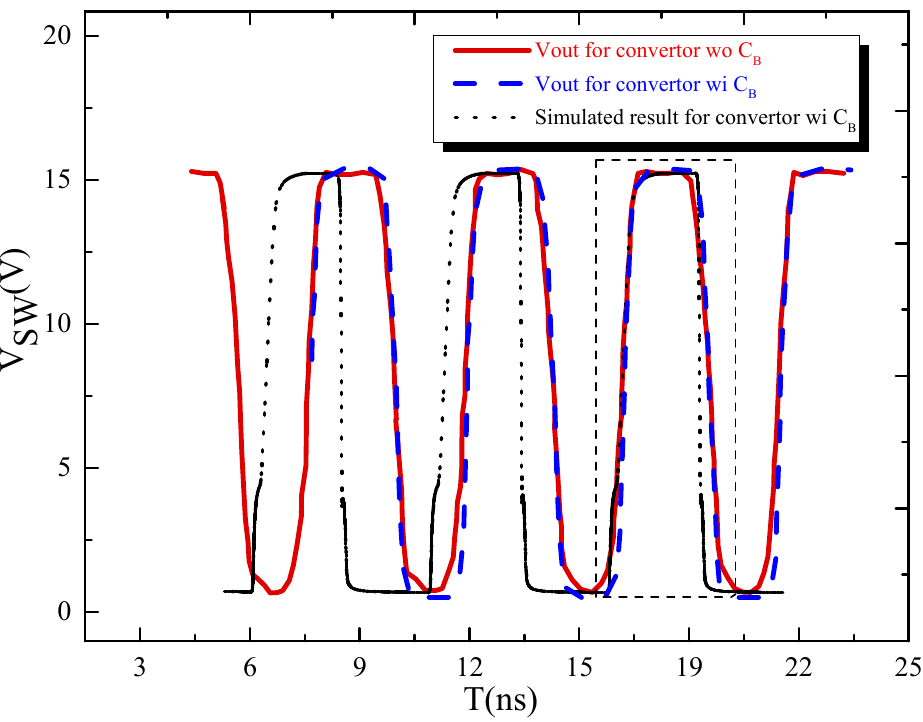
Figure 11. Comparison between the experimental output waveforms (of a converter with a bootstrapped capacitor and converter without a bootstrapped capacitor) and simulated output waveform (of a converter with a bootstrapped capacitor).